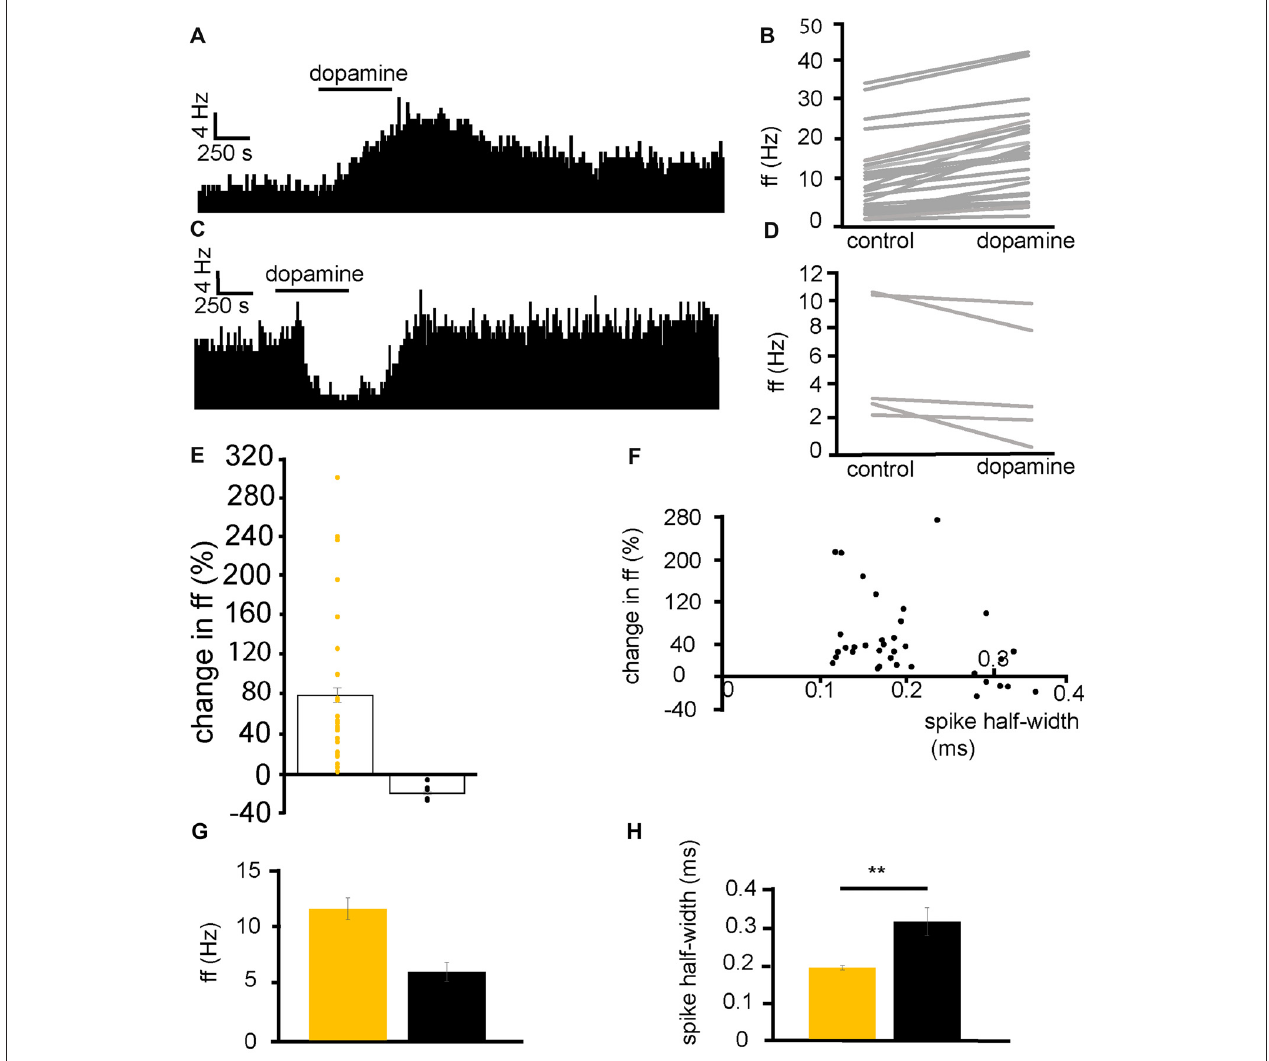
FIGURE 2 | Dopamine application has dual effects on VP neurons. (A) Excitatory response to dopamine application in a VP neuron. (B) Changes in firing frequency (ff) for 30 VP neurons in experiments similar to that illustrated in panel (A) . Firing frequency was measured before and during the application of dopamine. (C) Inhibitory response to dopamine application in a VP neuron. (D) Changes in firing frequency for five VP neurons in experiments similar to those illustrated in panel (C) . Firing frequency was measured before and during the application of dopamine. (E) Distribution of excitatory (yellow) and inhibitory (black) responses (% change compared to baseline) to dopamine application in VP neurons with their corresponding average values. (F) Spike half-widths (ms) for each neuron compared to % change in firing frequency in response to dopamine application. (G) Firing frequency for VP neurons excited by dopamine (yellow) and those inhibited (black). (H) Significant differences in spike half-width (ms) for VP neurons excited by dopamine application (yellow) and those inhibited (black). In this and following figures, ∗ P < 0.05 and ∗∗ P <